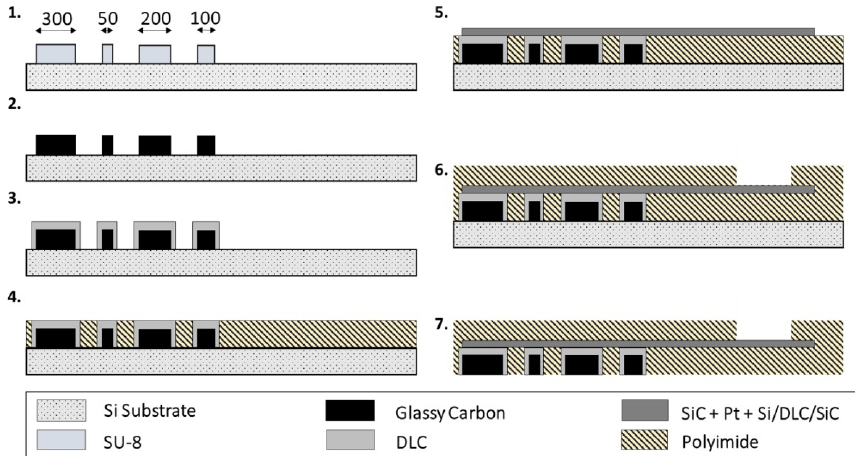
Figure 2. Microfabrication process used to fabricate the ultra‐conformable polyimide‐based ECoG devices with GC electrodes: ( 1 ) Lithographically patterned SU‐8 disks with diameters of 50, 100, 200 and 300 μm and height of 13 μm. ( 2 ) Pyrolysis of SU‐8 structures (1000 °C) to obtain GC electrodes. ( 3 ) PECVD (plasma‐enhanced chemical vapor deposition) of 50 nm DLC (diamond‐like carbon) onto GC electrodes. ( 4 ) First layer of polyimide (PI, 4 μm), patterned to open the vias to the GC electrodes. ( 5 ) PECVD of 50 nm SiC (silicon carbide) on the tracks of the devices, followed by evaporated platinum (Pt, 300 nm) and 50 nm Si/DLC/SiC. ( 6 ) Second layer of PI (4 μm), patterned to access the metal bump pads. ( 7 ) Buffered oxide etch (BOE) for releasing the devices from the silicon wafer. In short, SU‐8 3010 (MicroChem, Westborough, MA, USA) was spun on a silicon wafer and photolithographically patterned in 4 × 4 arrays of disk‐shaped structures with diameters of 50, 100, 200 and 300 μm and height of 13 μm. They were then pyrolyzed in a furnace (PEO 601, ATV‐